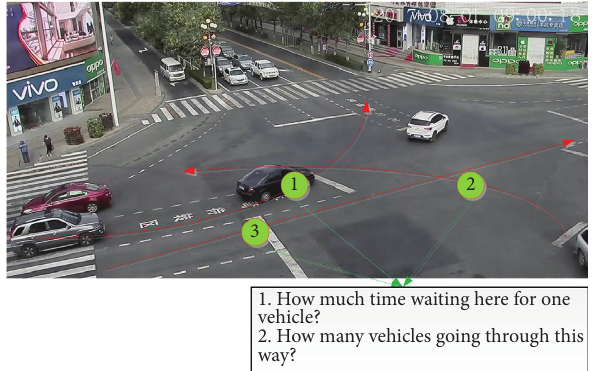
Figure 1: The description of fine-grained traffic